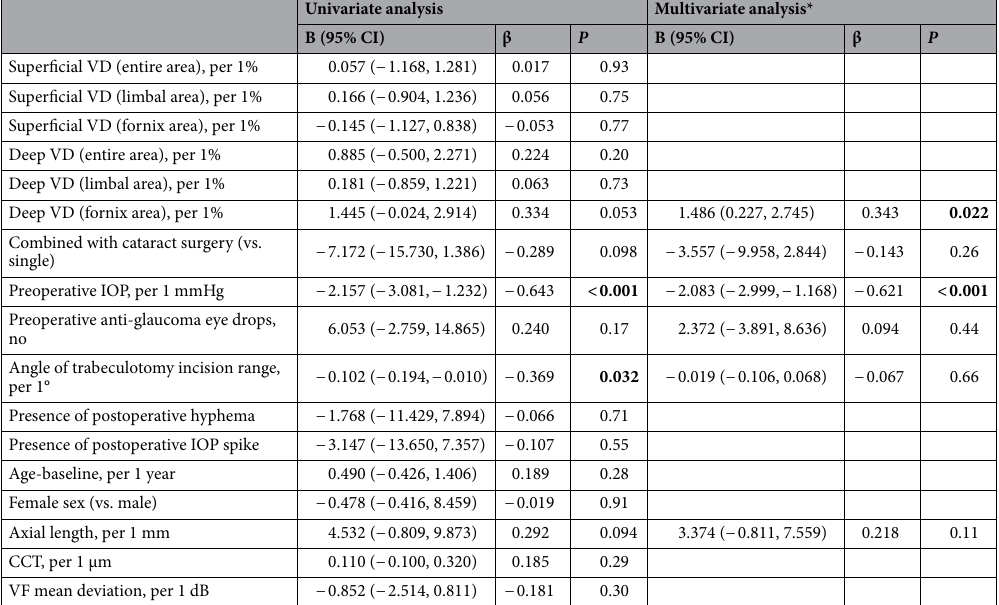
Table 4. Factor associated with the percent changes in intraocular pressure (IOP) (N = 34). Statistically significant values ( P < 0.05) are shown in bold. Percent changes in IOP = (postoperative IOP 1 year after the VF = visual field. *Multivariate analysis for combination with cataract surgery, preoperative anti-glaucoma eye drops, and all variables with P < 0.1 in a univariable regression